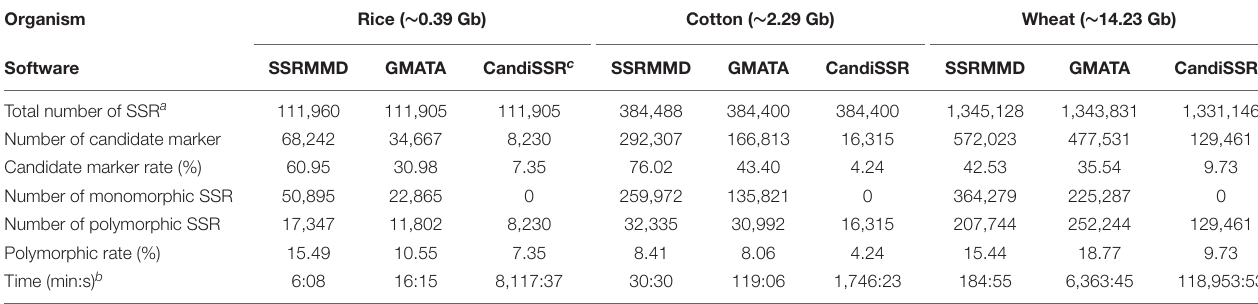
TABLE 3 | Performance comparison between SSRMMD and other two software programs for developing candidate polymorphic SSRs. Organism Rice ( ∼ 0.39 Gb) Cotton ( ∼ 2.29 Gb) Wheat ( ∼ 14.23